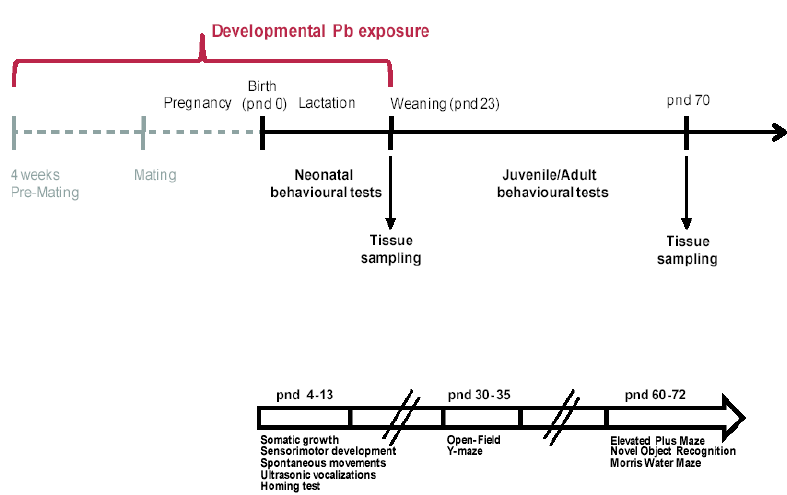
Figure 1. Timeline of the Experimental Design. Developmental lead (Pb) exposure (from 4 weeks pre-mating to offspring weaning), behavioral testing (neonatal and juvenile/adult tests) and tissue collection for Pb determination, in blood and brain, and Western blot on hippocampus at post-natal day 23 and 70 are indicated.